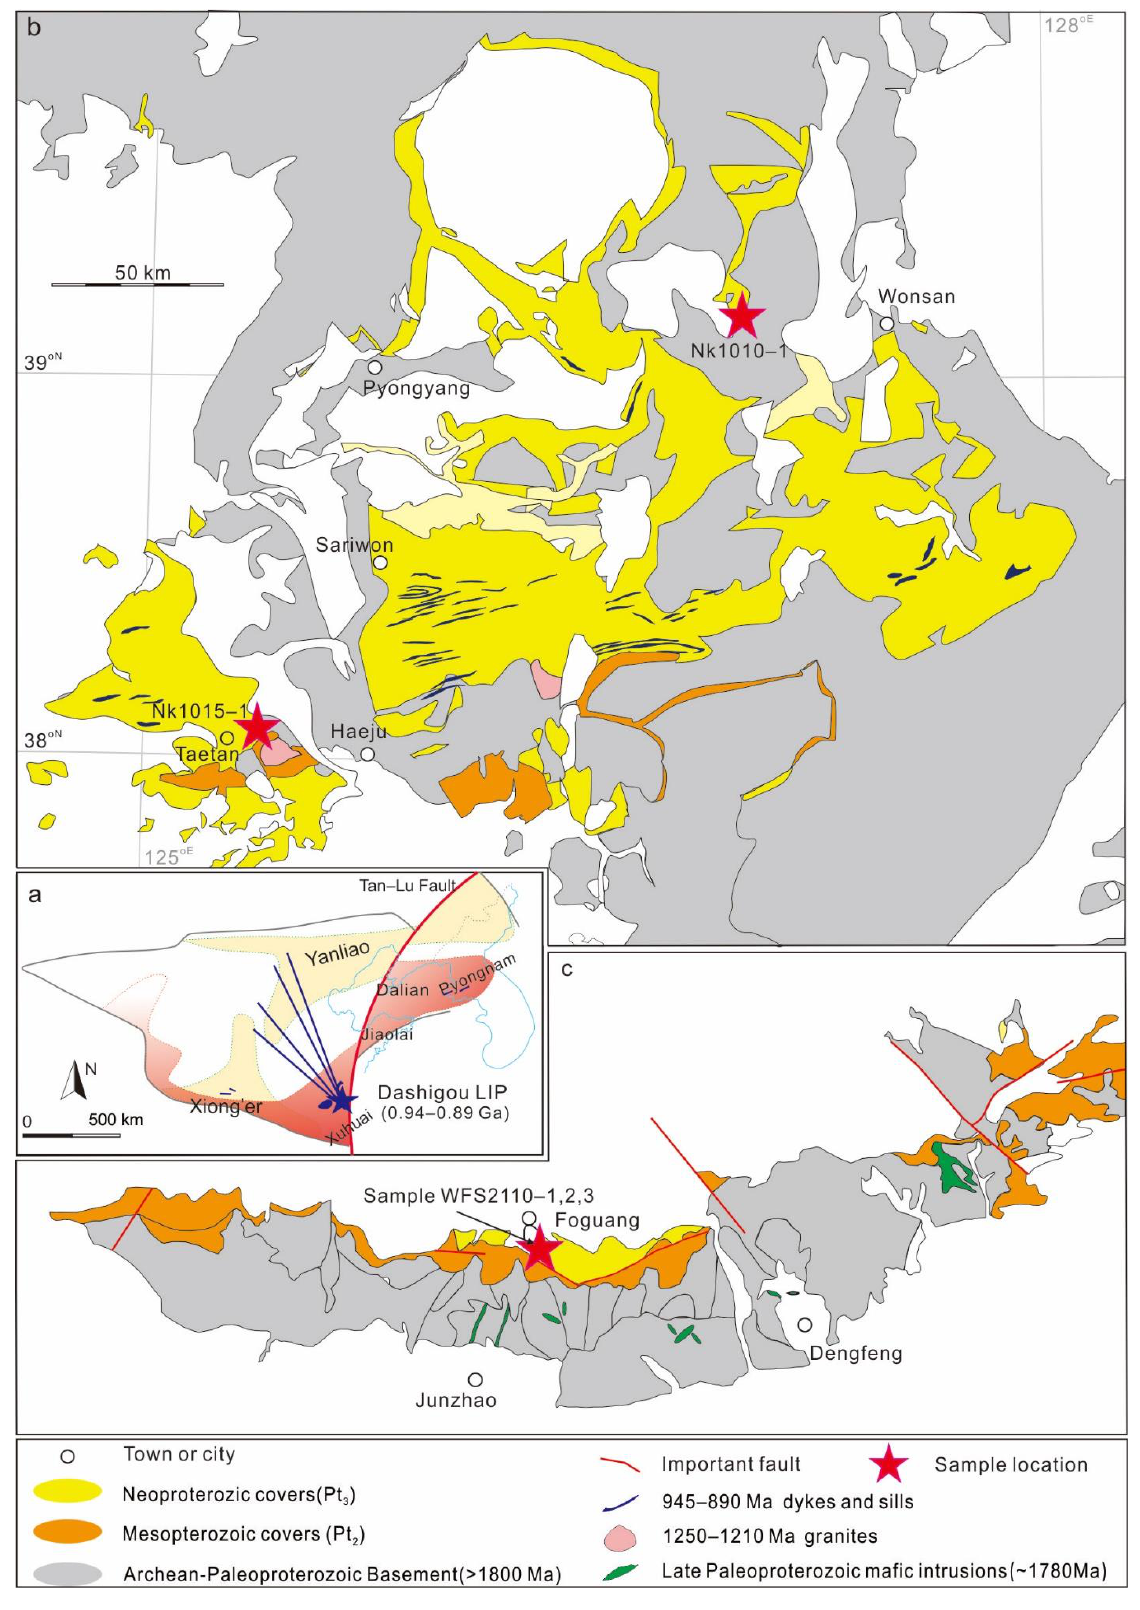
Figure 2 . Geological map of the (a) Early Neoproterozoic basins in NCC; ( b ) Pyongnam Basin [19] Figure 2. Geological map of the ( a ) Early Neoproterozoic basins in NCC; ( b ) Pyongnam Basin [19] and ( c ) Songshan area [20]. and ( c ) Songshan area